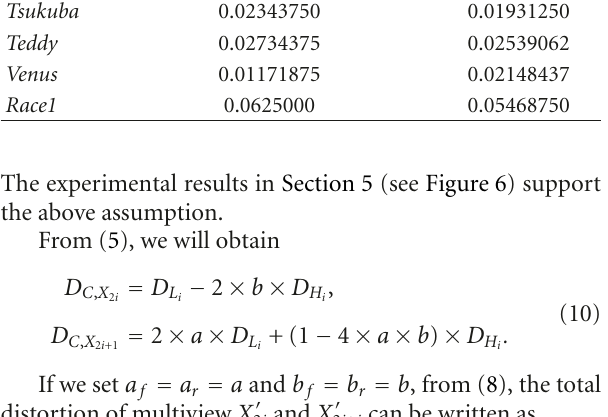
Table 2: The average of f and r ratio of di ff erent test images. Test